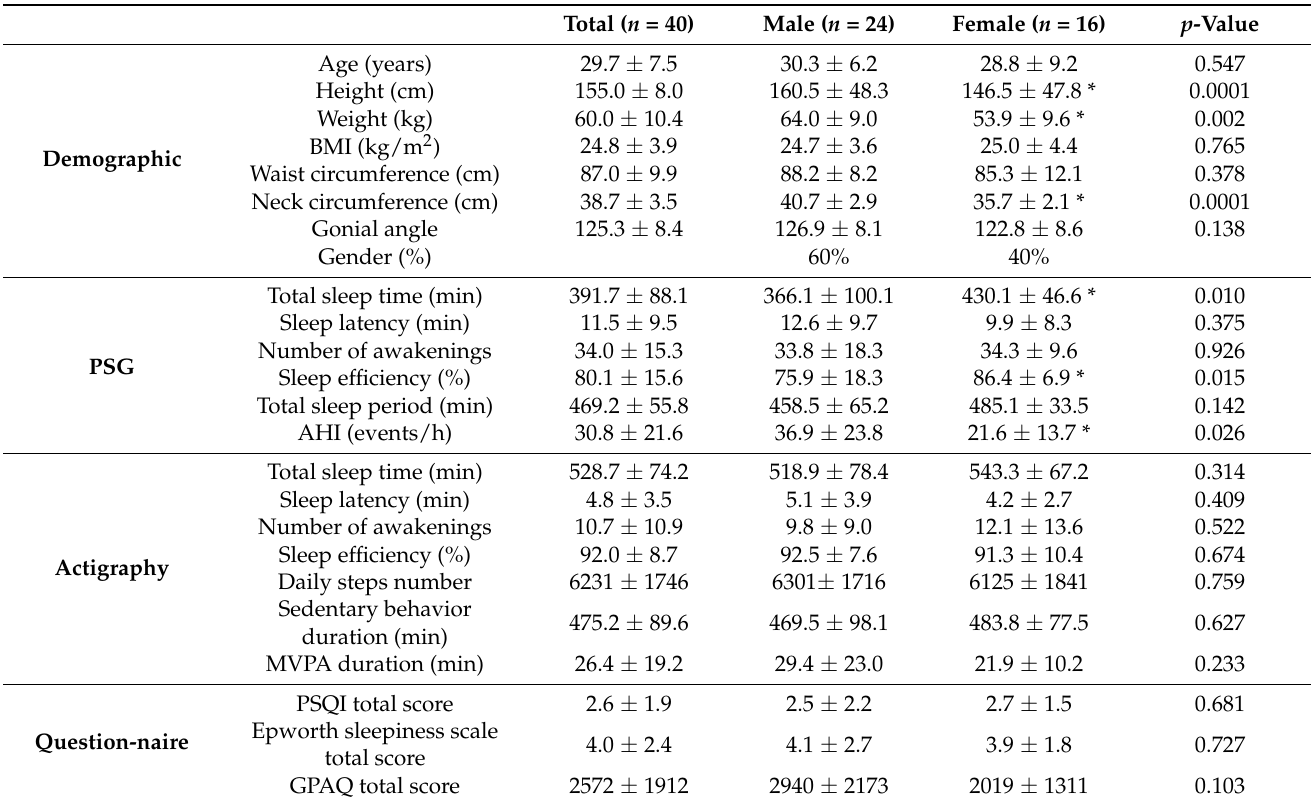
Table 1. Descriptive